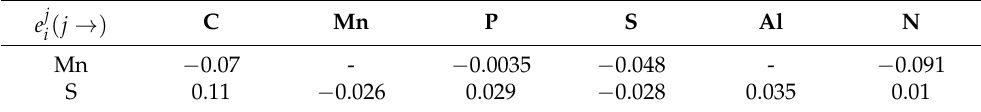
Table 4. First order interaction coefficients related to MnS